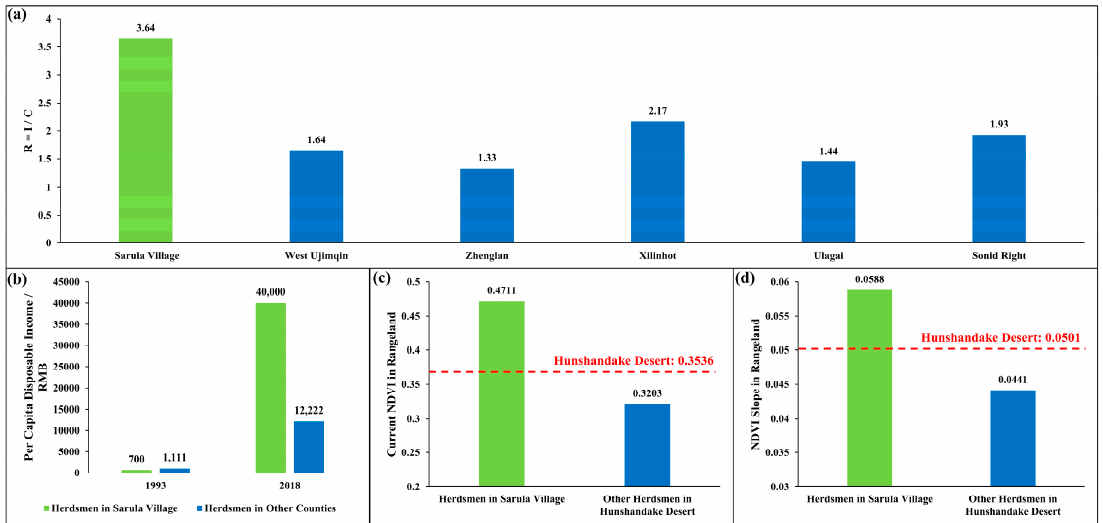
Figure 4. (a) Income–cost ratio; (b) Per capita disposable income; (c) current NDVI; and (d) NDVI slope inside rangelands Figure 4. ( a ) Income–cost ratio; ( b ) Per capita disposable income; ( c ) current NDVI; and ( d ) NDVI of herdsmen in Sarula village and other counties. slope inside rangelands of herdsmen in Sarula village and other